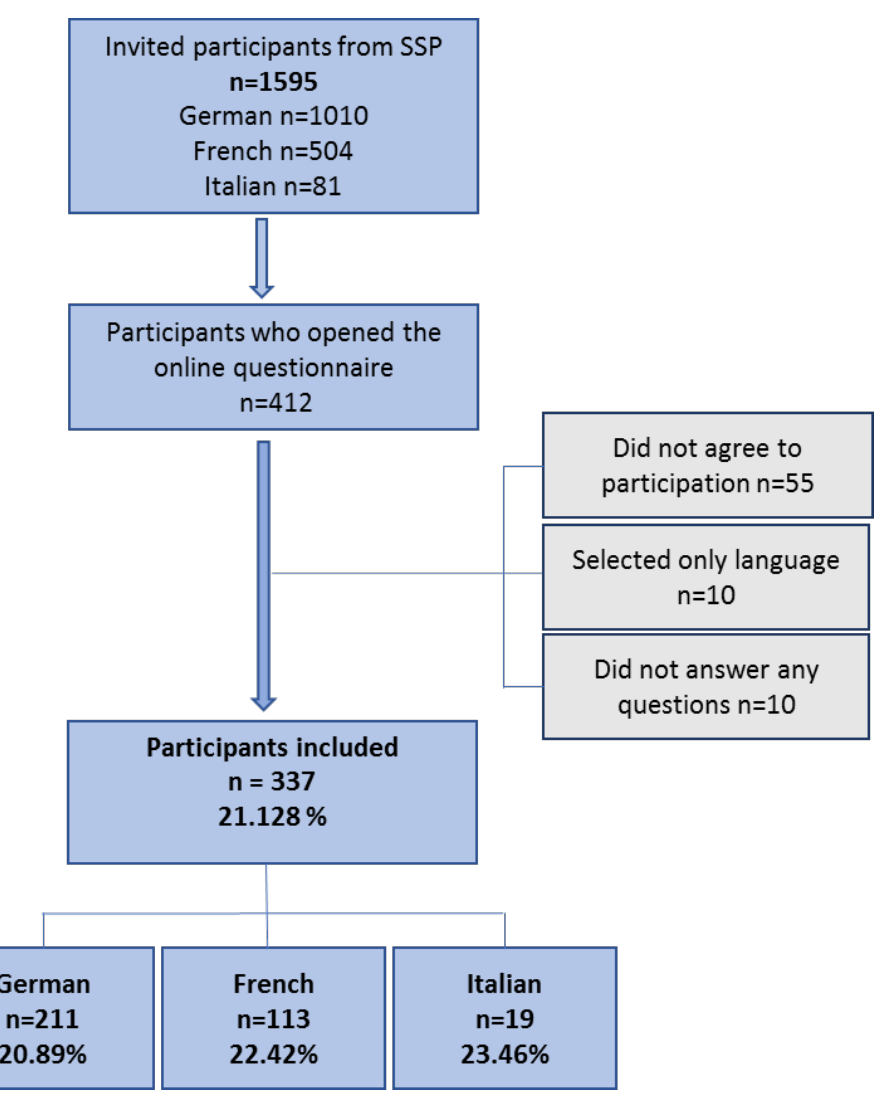
Figure S1. Flow chart of study